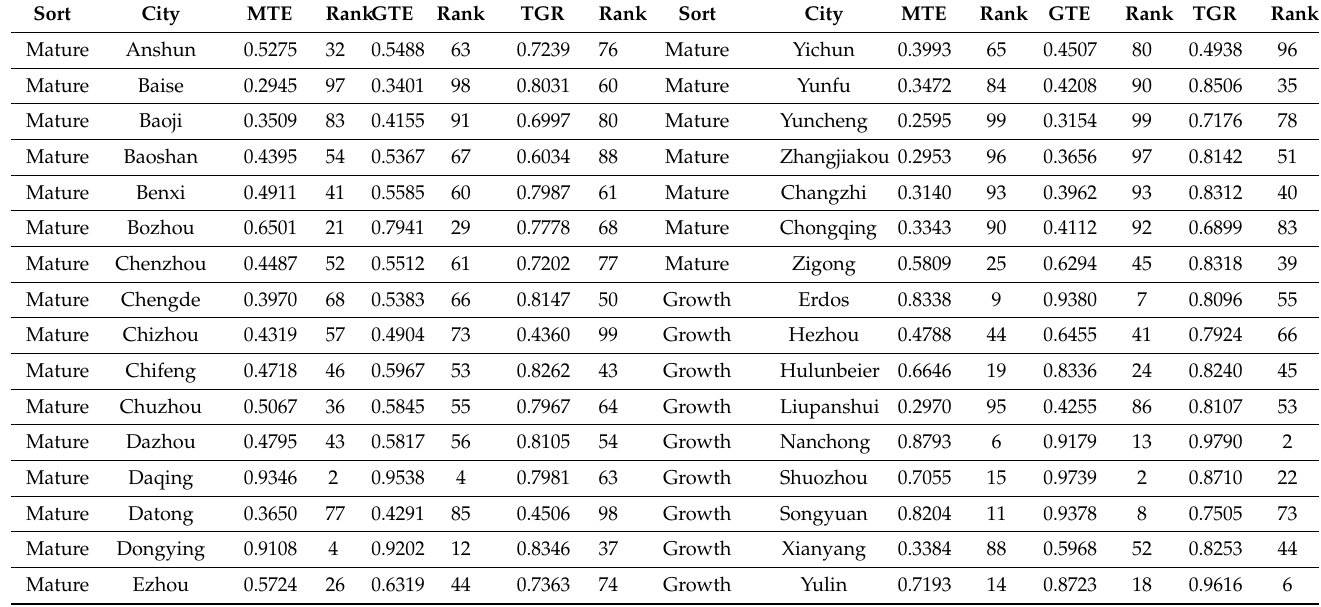
Table A1. Statistical description of input-output allocation efficiency of mining cities from 2006 to